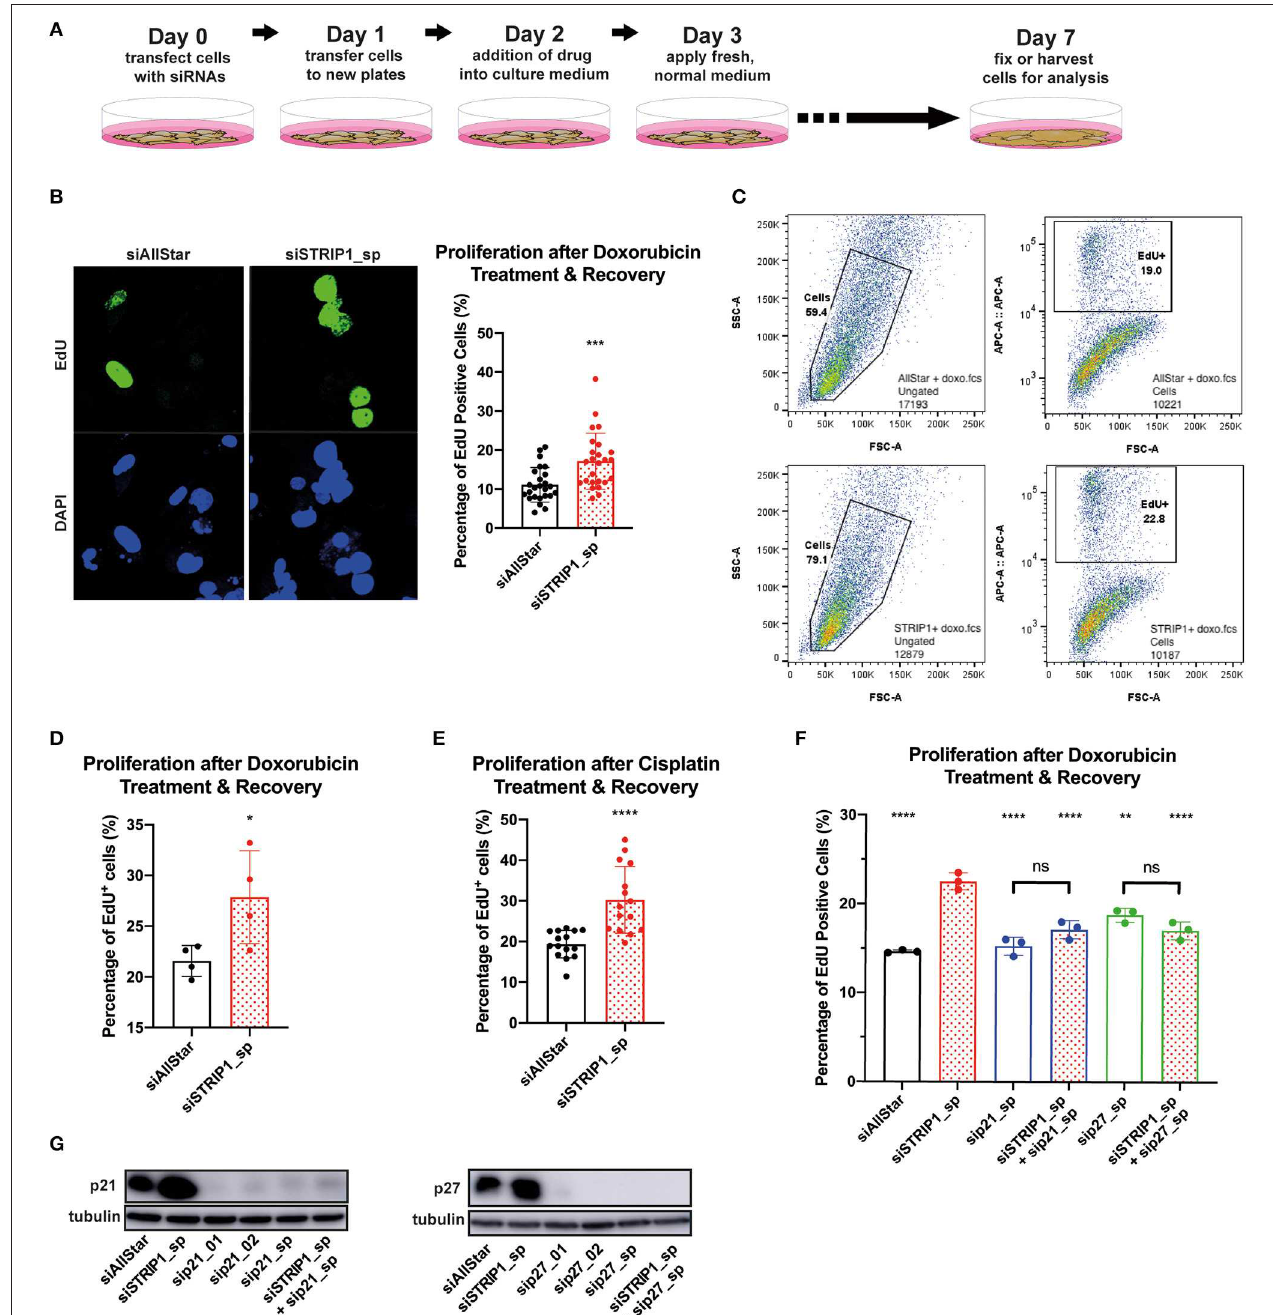
FIGURE 5 | STRIP1 regulates proliferation-senescence cell fate after chemotherapy. (A) Experimental set-up of the drug treatment experiment. (B–F) siRNA-depleted MDA-MB-231 cells were treated with low dose chemotherapy for 24h and allowed to recover for a further 96h. EdU was added to cells in culture 2h prior to fixation/harvesting and analyzed for proliferation status. (B) Immunofluorescence quantification and representative images show increased EdU + cells after loss of STRIP1 with doxorubicin treatment. (C) Gating strategy for EdU proliferation flow cytometry analysis. Side scatter area and forward scatter area were used to obtain the whole cell population (Cells). The population is then analyzed according to EdU intensity (APC conjugated) against forward scatter area to identify proliferative cells (EdU + ). (D) Flow cytometry quantification shows increased EdU + cells after loss of STRIP1 with low dose doxorubicin treatment and subsequent recovery. (E) Immunofluorescence quantification of EdU + cells shows increased proliferation after loss of STRIP1 with low dose cisplatin treatment and recovery. (F) Flow cytometry quantification of STRIP1 and p21 or p27 co-depleted cells with decreased EdU + populations compared to STRIP1-depleted cells. Statistical analysis was compared to siSTRIP1 unless indicated. All immunofluorescence and flow cytometry analyses were conducted at least three independent times. (G) p21 and p27 protein knockdown efficiencies of siRNA-depleted MDA-MB-231 cells were demonstrated by immunoblotting. All statistical tests were performed using parametric t -test or one-way ANOVA, * P < 0.05, ** P < 0.01, *** P < 0.001, **** P < 0.0001 to siAllStar unless indicated.